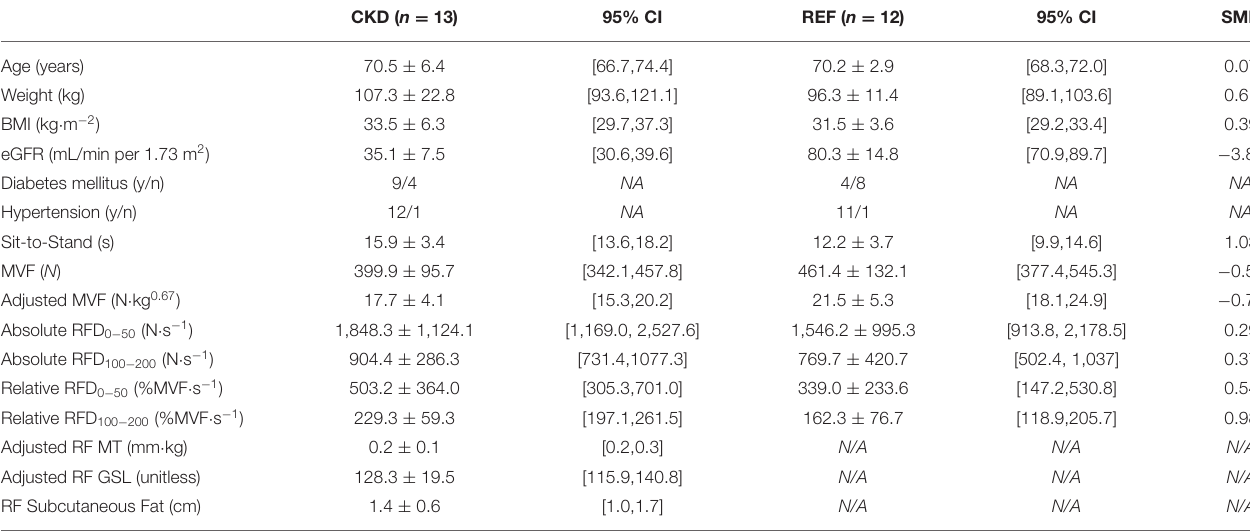
TABLE 1 | Participant demographics.